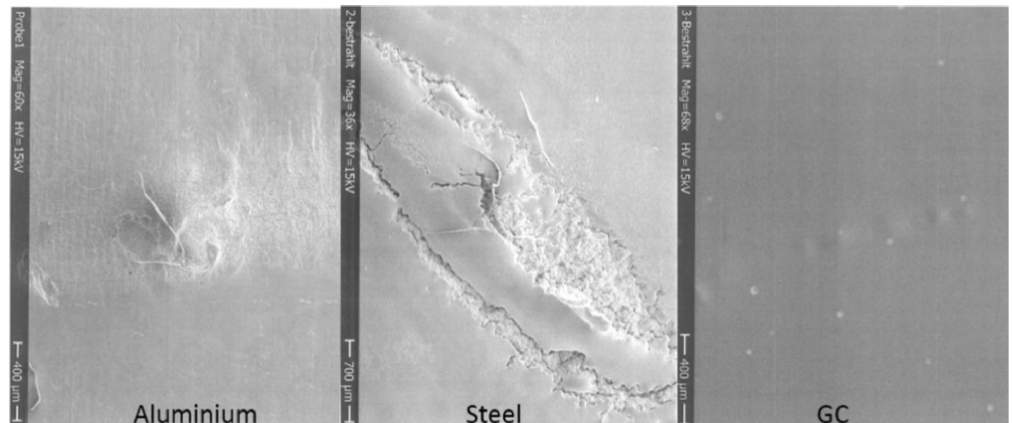
FIG. 20. Photos of the irradiated target areas after 8 h of beam irradiation. The scale is marked on the lower left of each